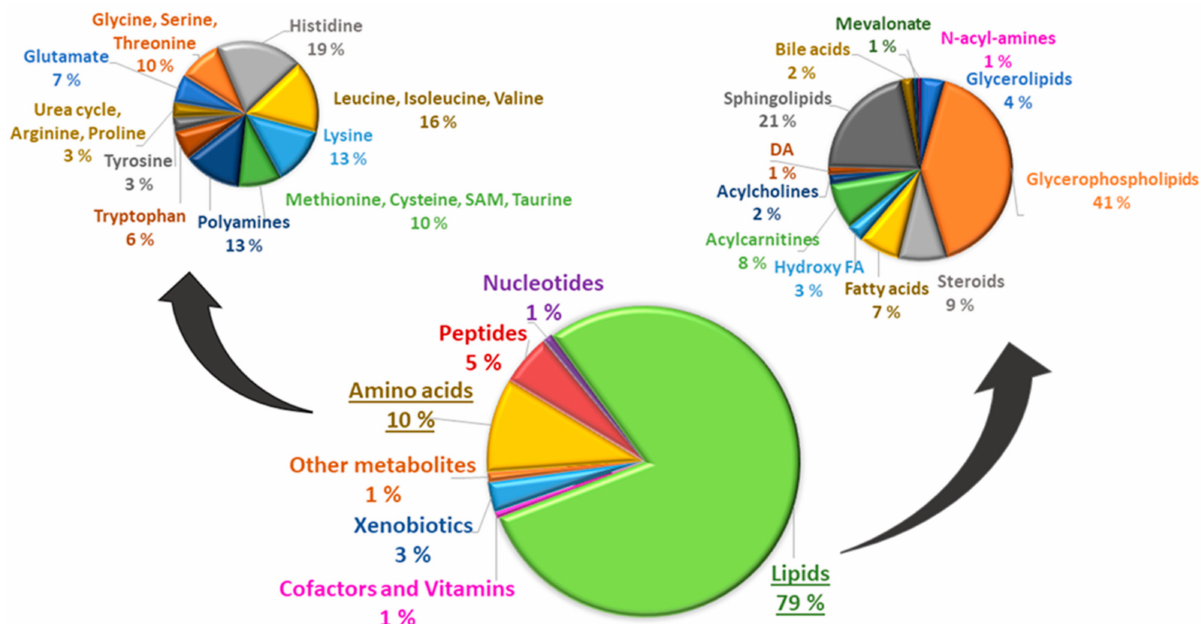
Figure 1. Lipids (79%) and amino acids (10%) were the most frequent groups of metabolites in 7532 participants included in our study. Among the lipids, glycerophospholipids (41%) were the most frequent subgroup of lipids, and histidine (19%) the most frequent subgroup of amino